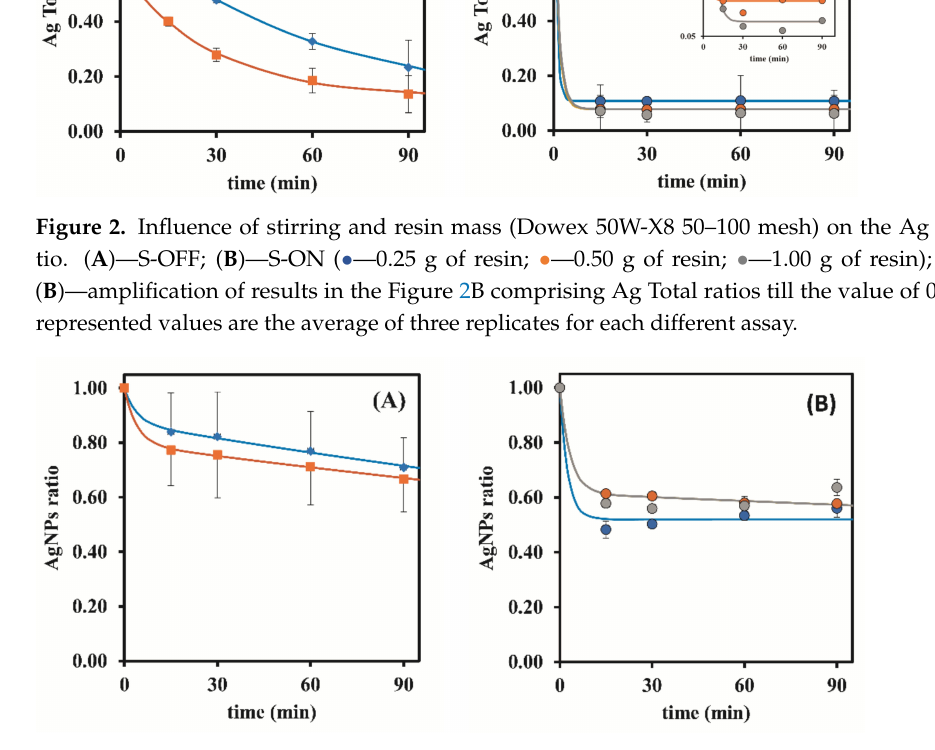
Figure 3. Influence of stirring and resin mass (Dowex 50W-X8 50–100 mesh) on the AgNPs ratio. ( A )—S-OFF; ( B )—S-ON ( • —0.25 g of resin; • —0.50 g of resin; • —1.00 g of resin). The represented values are the average of 3 replicates for each different